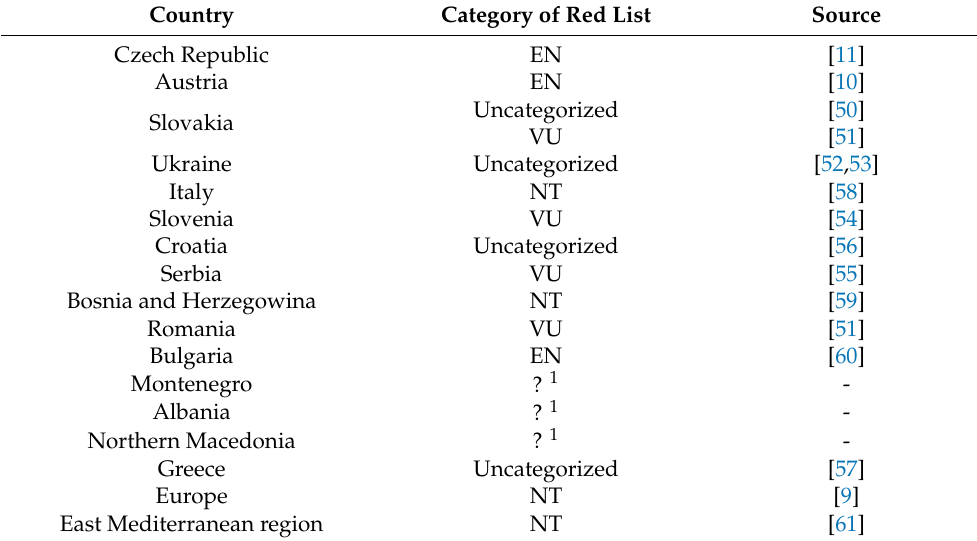
Table 5. C. heros and its national conservation status in national Red Lists in its distribution range. Country Category of Red